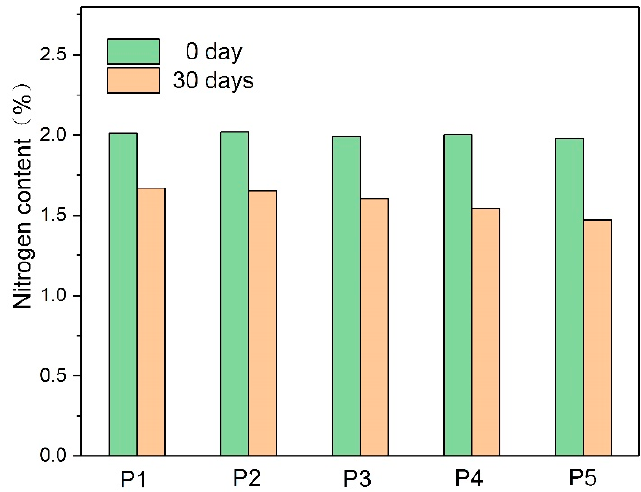
Figure 2. The nitrogen content of the different amine compounds.